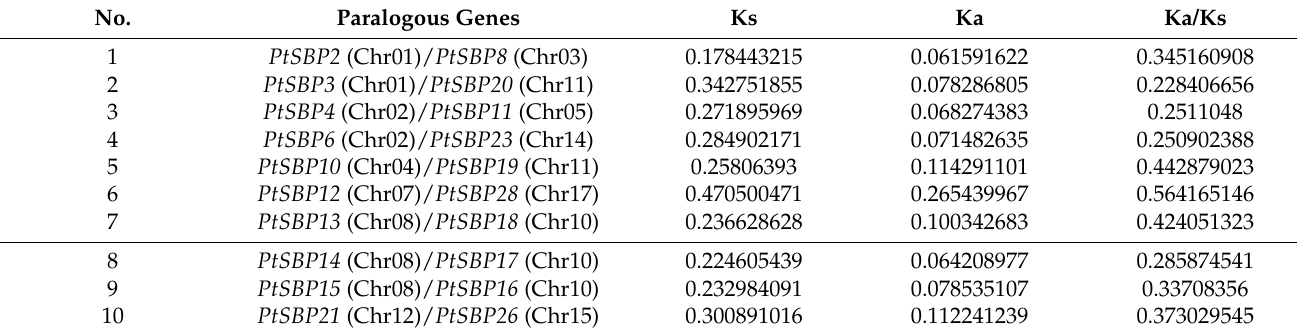
Figure 4. ( A ) Analysis of gene segmental duplication. The distribution of 30 SBP genes on poplar chromosomes, with segmental duplication relationships represented by blue lines. ( B ) Nonsynonymous (Ka) and synonymous (Ks) ratio analysis of gene replication driving force. The x-axis represents Ks, the y-axis represents Ka, the black line represents Ka/Ks = 1, and the red dot represents the Ka/Ks replacement rate of 10 segmental repetitive events. Table 2. Ka, Ks and Ka/Ks ratio for paralogous PtSBP genes.